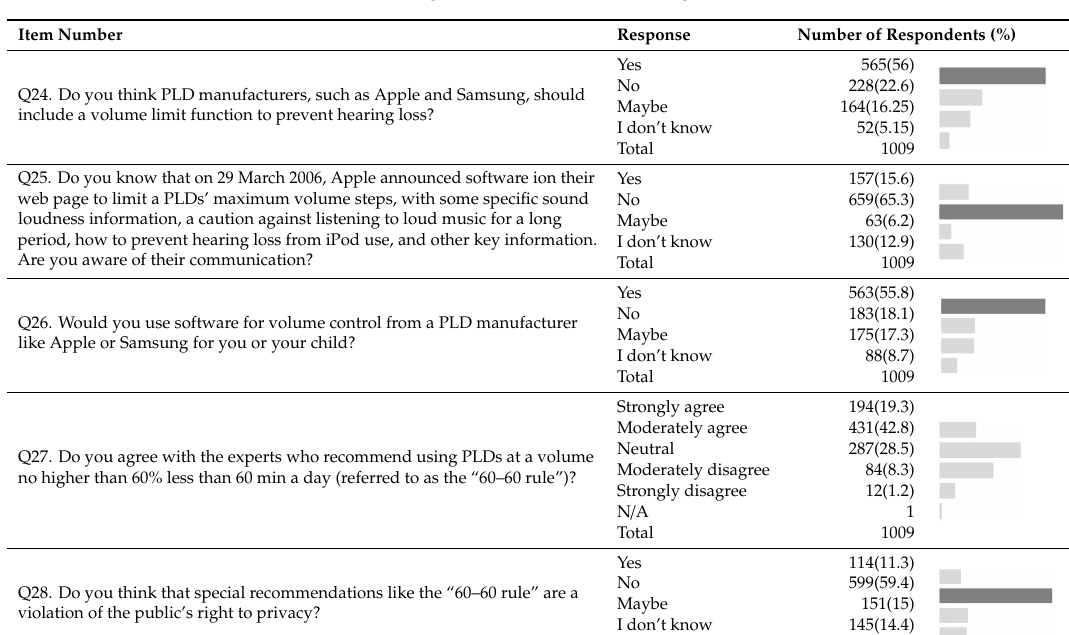
Table A8. Knowledge and attitude toward regulation of